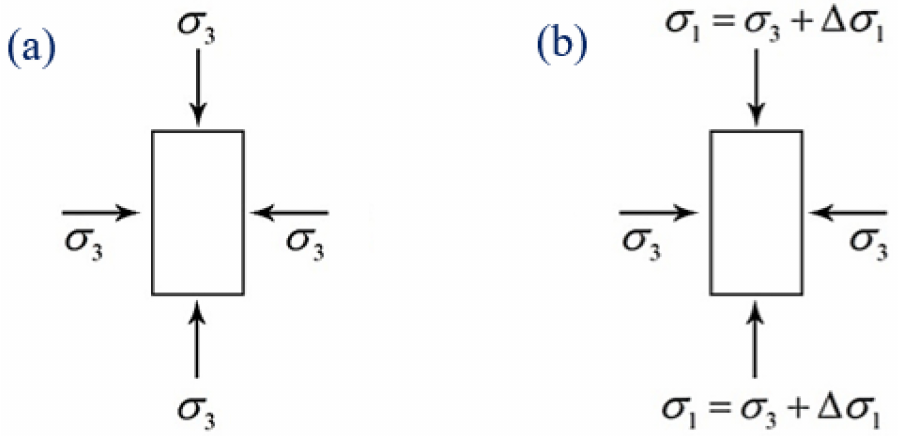
Figure 4. Stress state of triaxial compression: ( a ) the initial state upon adding confining pressure; ( b ) the stress state after axial pressure is